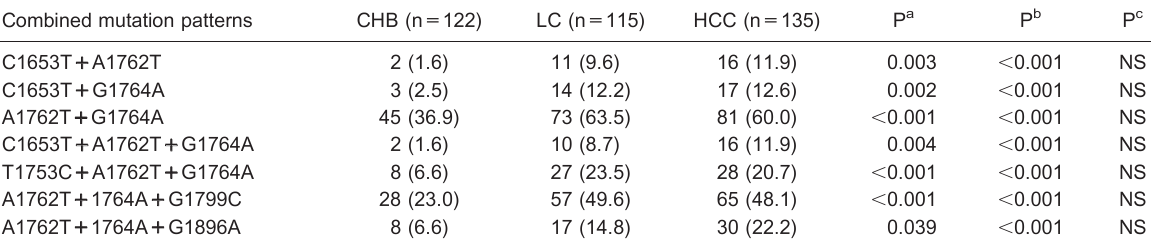
Table 6. Combined mutations in the enhII/BCP/precore regions of HBV. Combined mutation